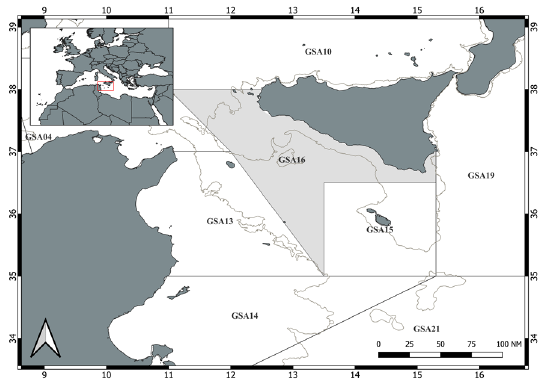
Figure 1. Strait of Sicily (GSA 16) map with the study area (shadowed). The grey line represents the 250 m isobath.